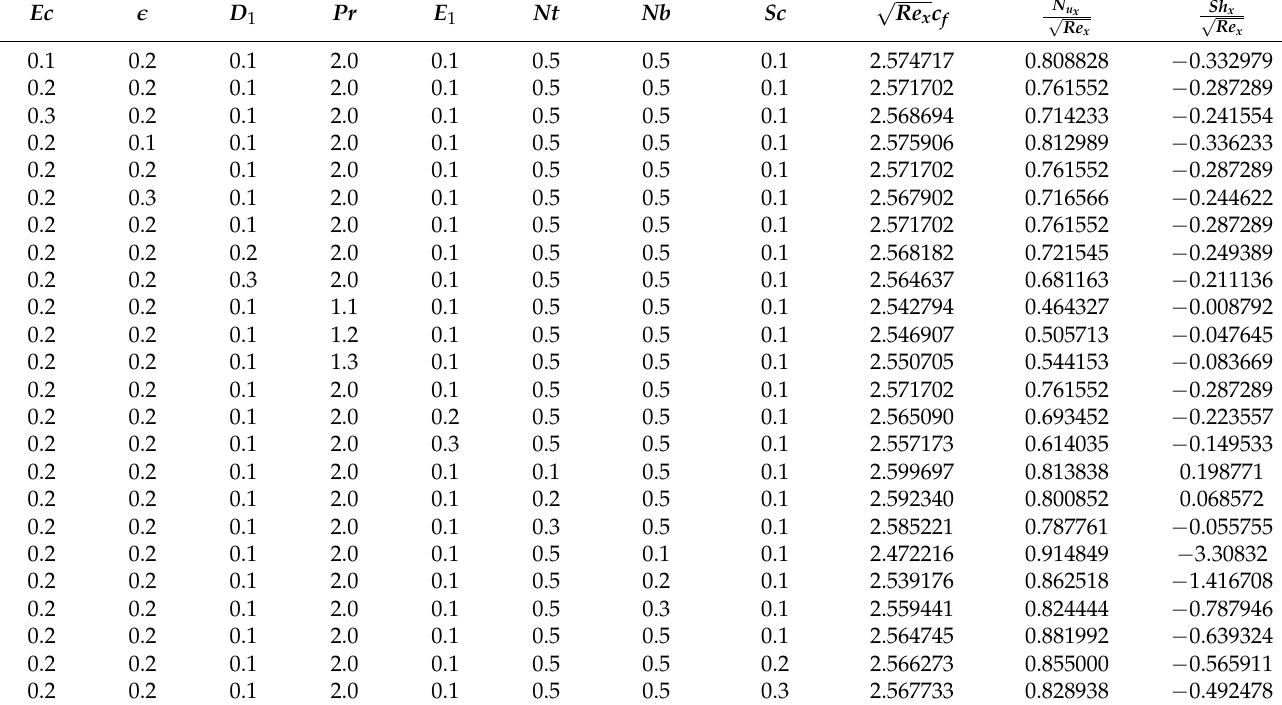
Table 3. Values of c f , for several values of Ec , (cid:101) , D 1 , Pr, E 1 , Nt , Nb , and